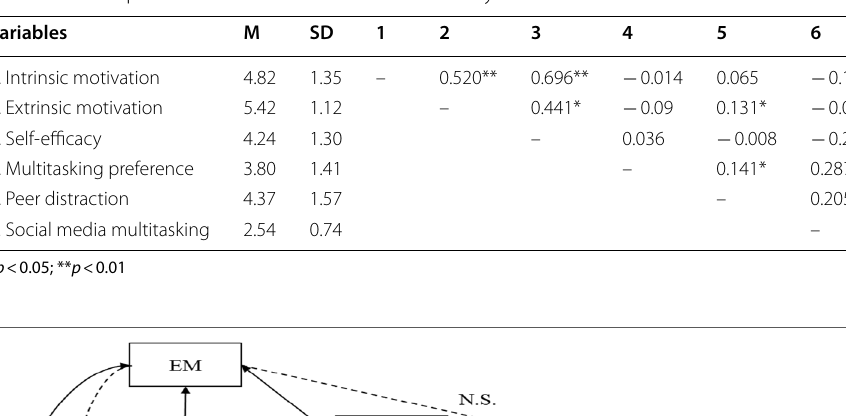
Table 1 Descriptive data and results of correlation analysis